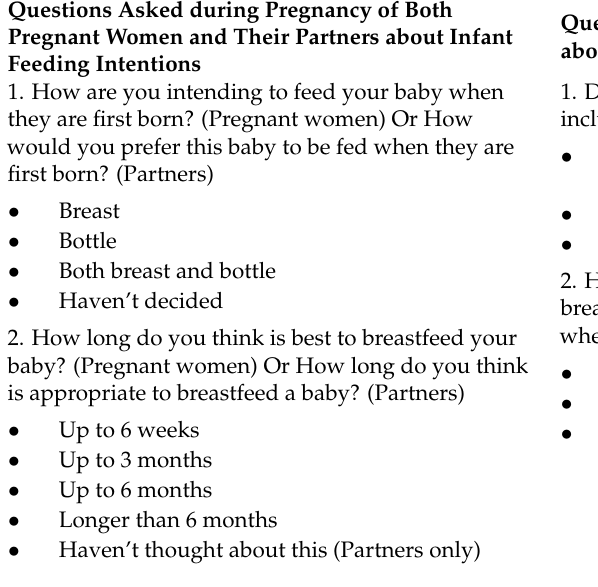
Box 1. Questions asked of pregnant women and their partners about infant feeding intentions and